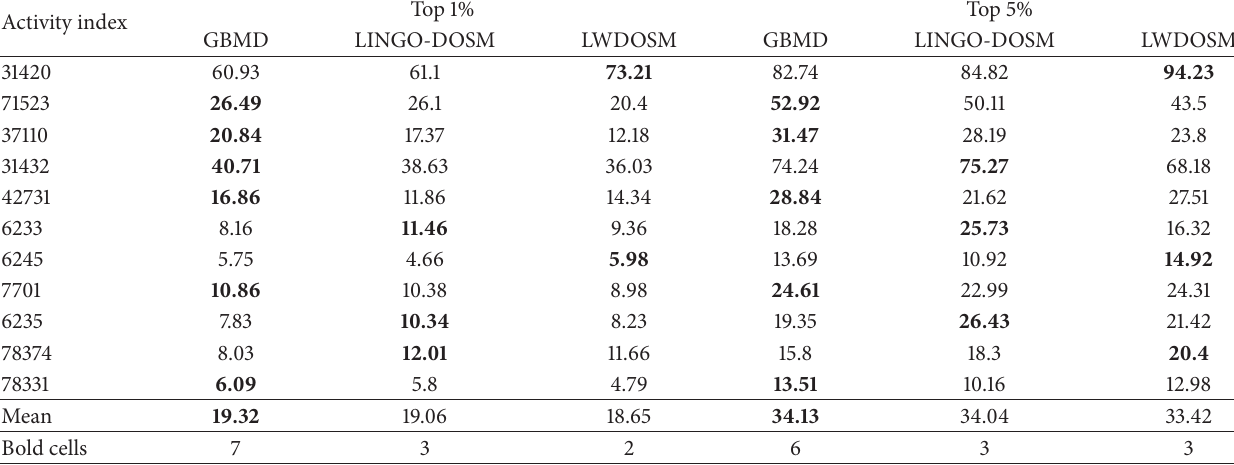
Table 12: Retrieval results of top 1% and 5% for data set DS1 compared with LWDOSM and